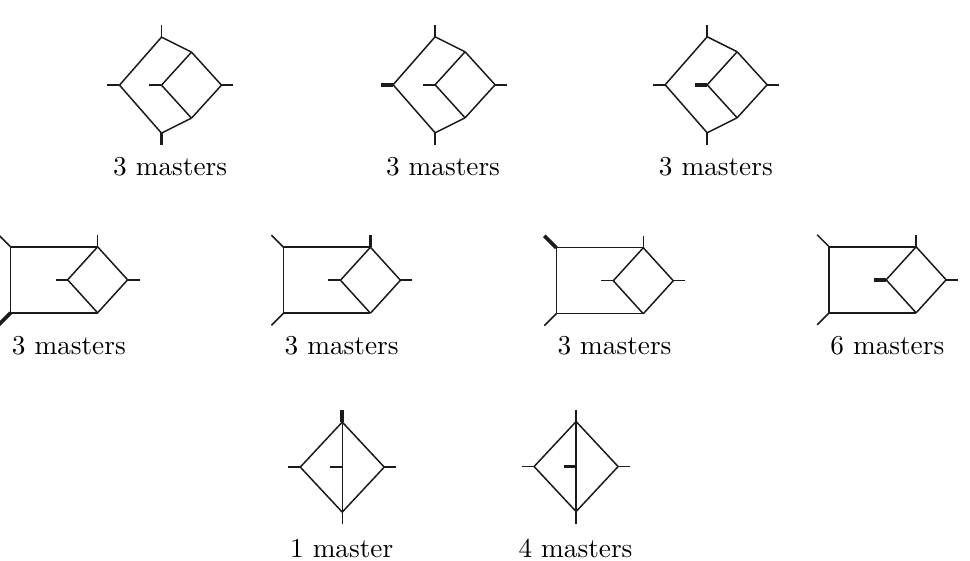
Figure 2. Propagator structures of two-loop five-point non-planar master integrals in the hexa-box